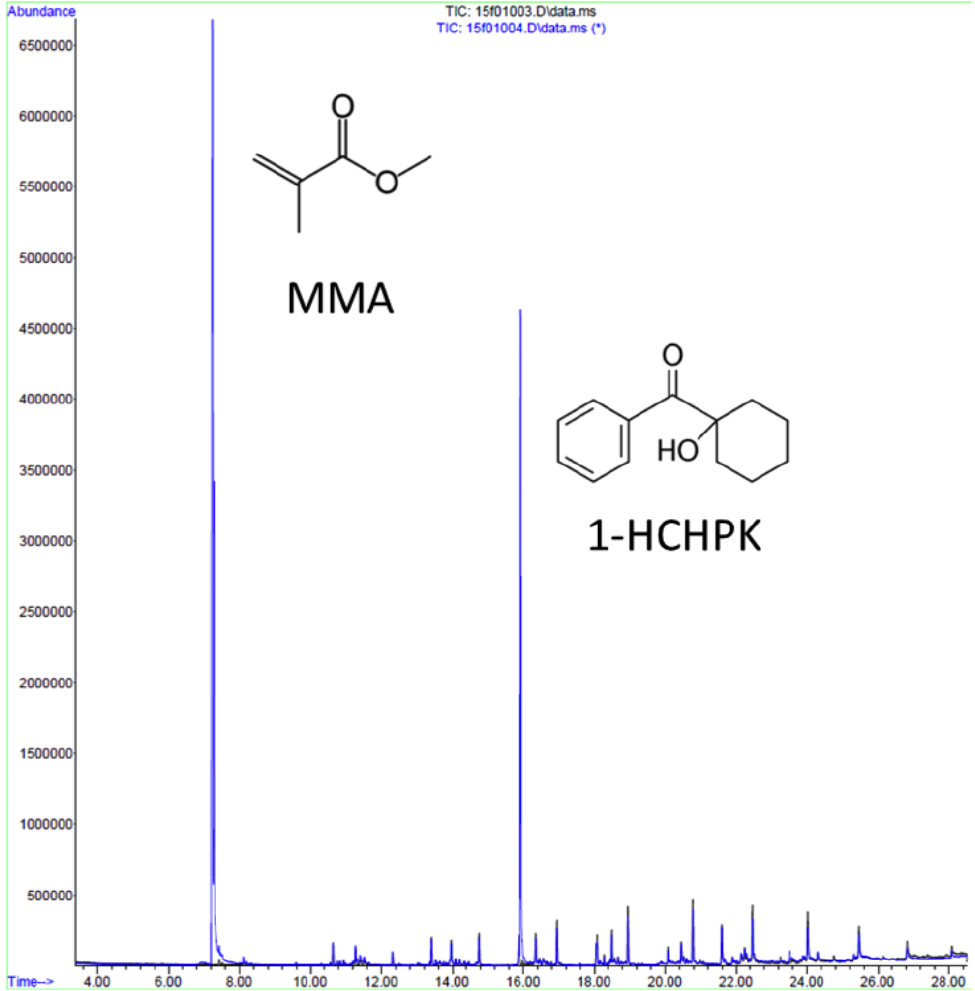
Figure 3. Qualitative analysis of Form Labs photopolymer leachate using gas